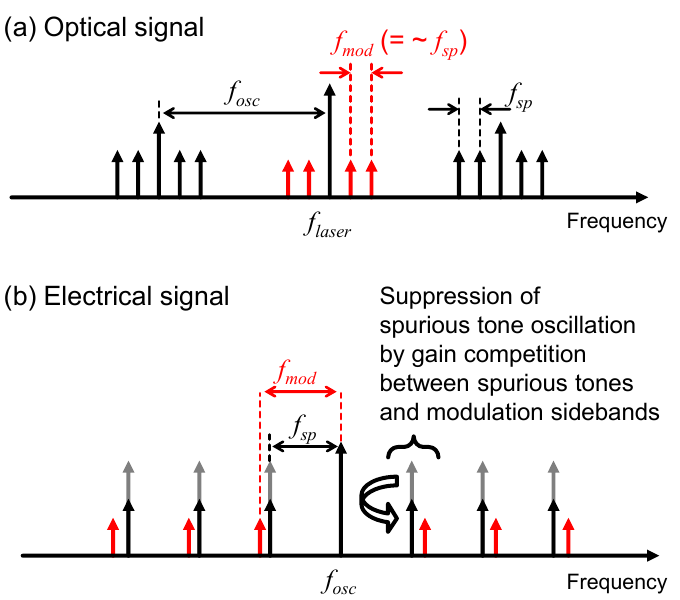
Figure 1. Principle of spurious tone reduction in an OEO signal based on laser direct modulation with a low-frequency RF signal. The plots are ( a ) optical signal of an RF-modulated single-loop DM-OEO and ( b ) electrical signal of single-loop DM-OEO. f osc : oscillation frequency of DM-OEO; f laser : center frequency of a laser; f mod : frequency of RF-modulation signal; f sp : interval of spurious tones.